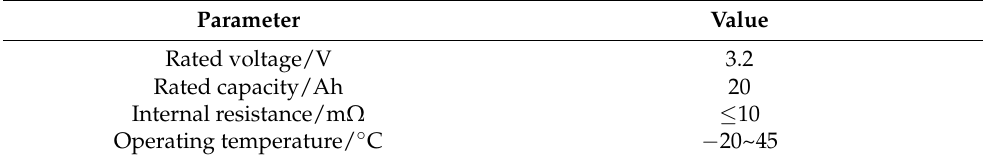
Table 2. Parameters of Li-ion battery unit.